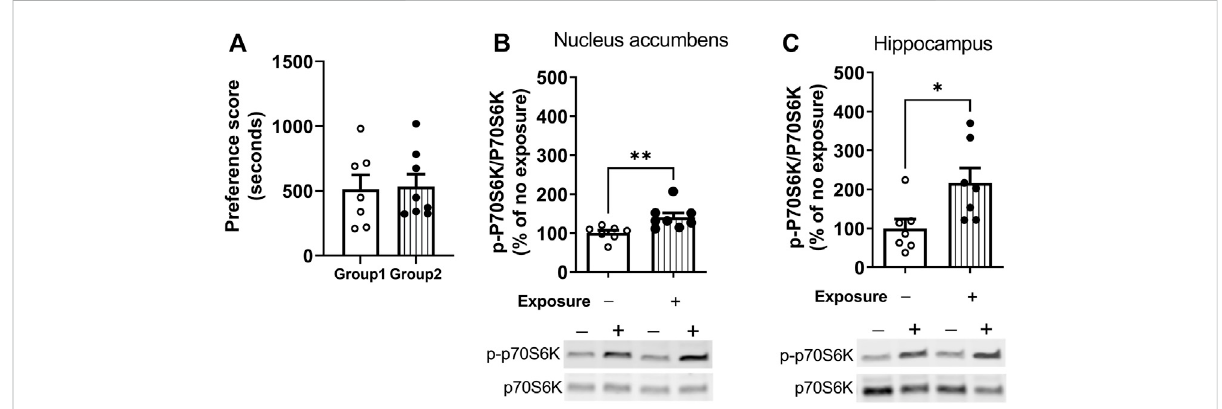
FIGURE 2 Regulation of mTORC1 activity in the nucleus accumbens and hippocampus after reactivation of cocaine memories. Place conditioning with cocaine 10 mg/kg occurred once daily for 8 days (A) Cocaine place preference scores from day 9 are shown; similar preference for the cocaine- paired compartment was found for two groups of mice. On day 10, mice were re-exposed to the cocaine compartment for 10 min to reactivate cocaine contextual memories (exposure group) or left in home cage (no exposure control group), and brains harvested 60 min later. Levels of phospho-p70S6K (p-p70SK6) and total p70S6K were quanti fi ed by Western blot and expressed as a ratio of p-p70S6K/p70S6K for each sample. p-p70S6K was signi fi cant induced 60 min following reactivation of cocaine memories in nucleus accumbens (B) and hippocampus (C) , as shown by comparison of the exposure group with no exposure controls. Mean ratio of p-p70S6K/p70S6K for the no exposure controls is set to 100% and data points are expressed relative to 100% of no exposure controls. * p < 0.05, ** p < 0.01 exposure vs. no exposure. Data are expressed as means ± SEM. N = 7 –